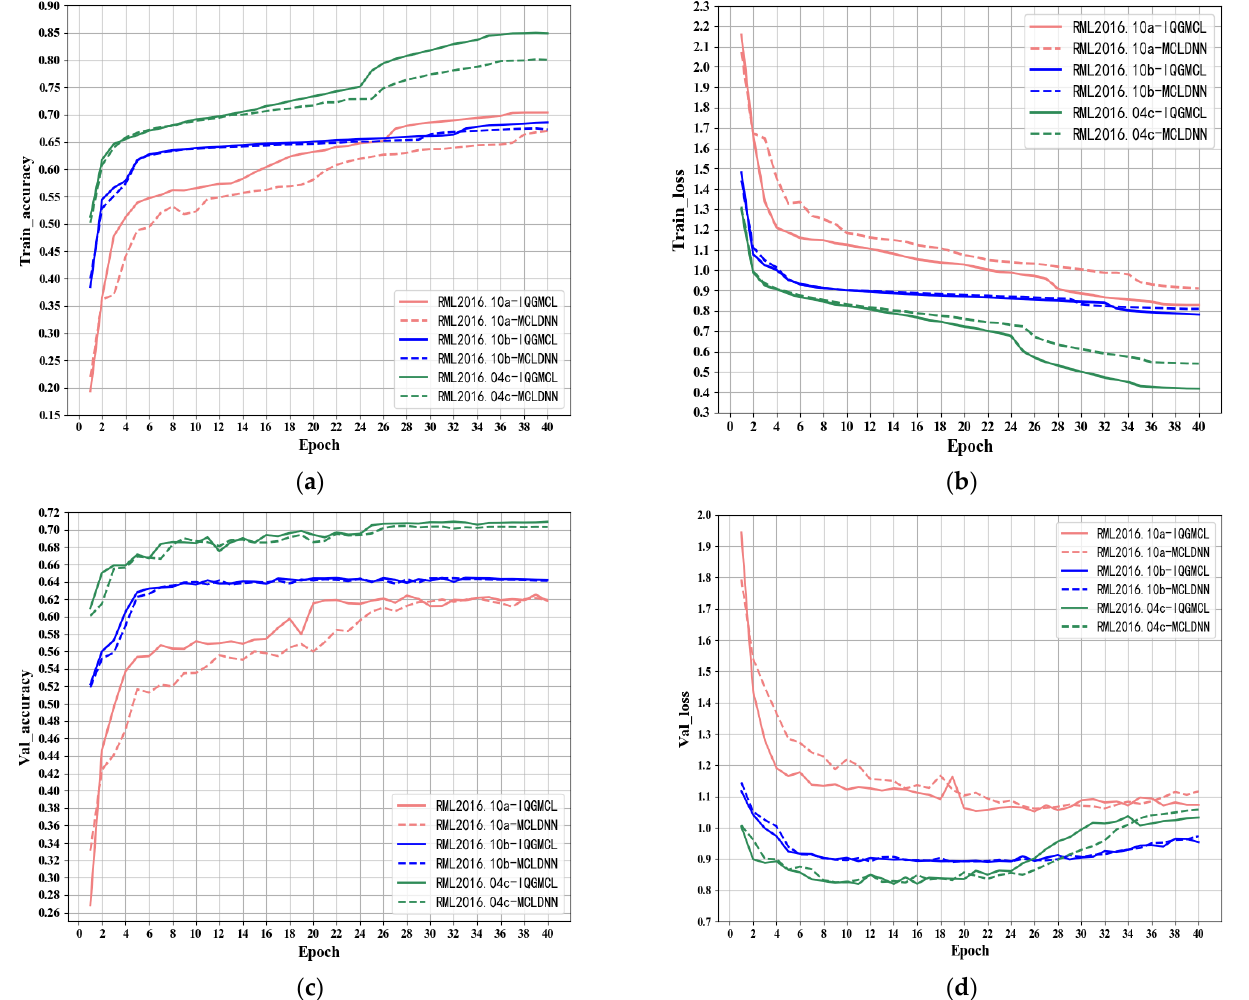
Figure 10. Training and validation process curves. ( a ) Train-accuracy contrast; ( b ) Train-loss contrast; ( c ) Val-accuracy contrast; ( d ) Val-loss contrast.